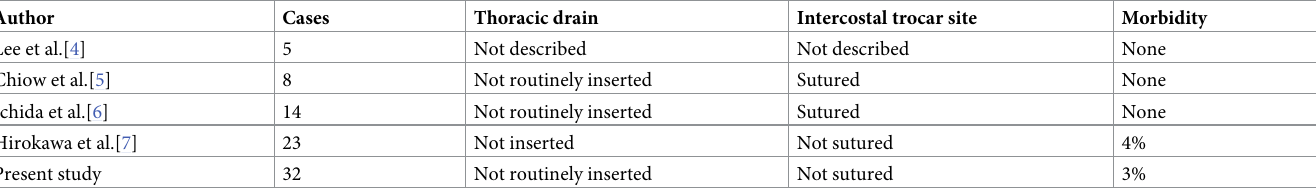
Table 3. Application of intercostal trocars for laparoscopic hepatectomy in current and previous